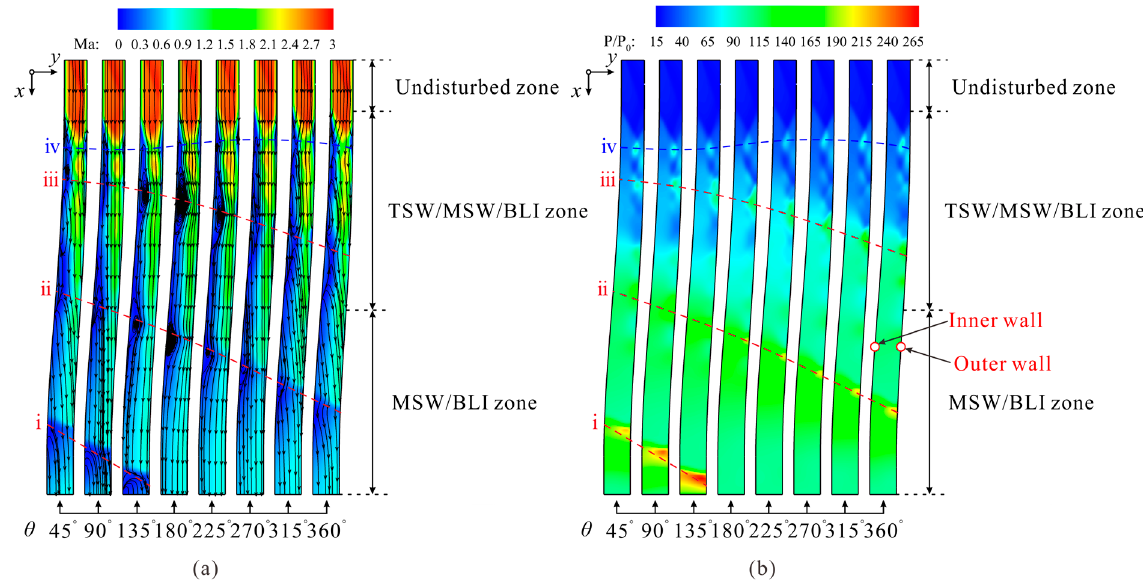
Figure 7. Flow patterns on eight meridian planes of different angles. ( a ) Mach number contours. ( b ) Pressure contours.